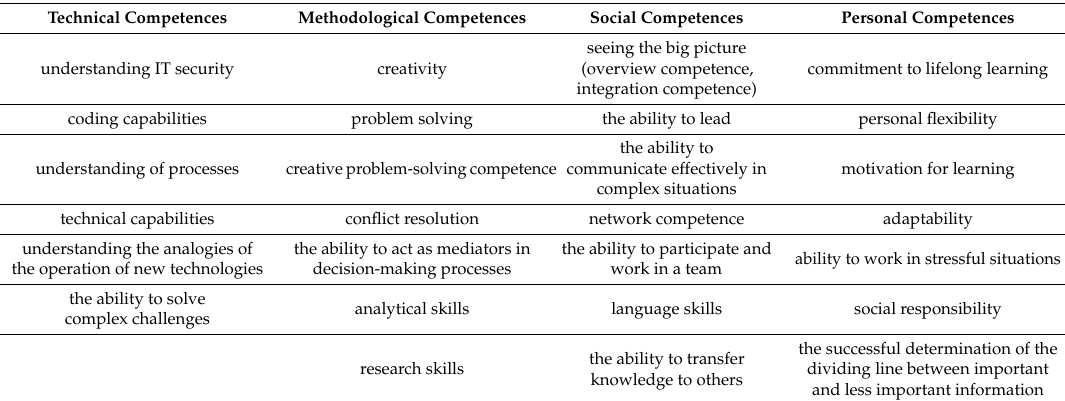
Table 3. The classification of